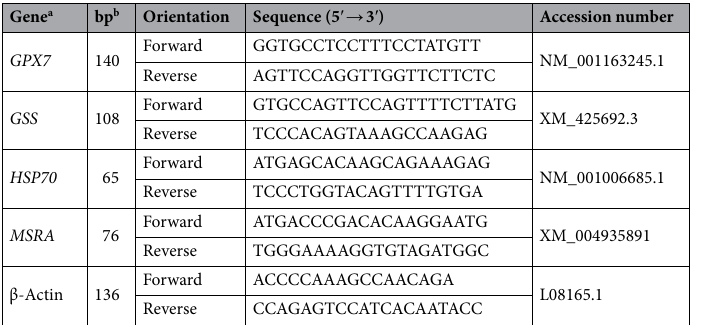
Table 8. Primers used in RT-qPCR. a GPX7 glutathione peroxidase 7 gene, GSS glutathione synthetase gene, HSP70 heat-shock protein 70 kDa gene, MSRA methionine sulfoxide reductase A gene. b bp base pairs. The annealing temperature was 60 °C for all